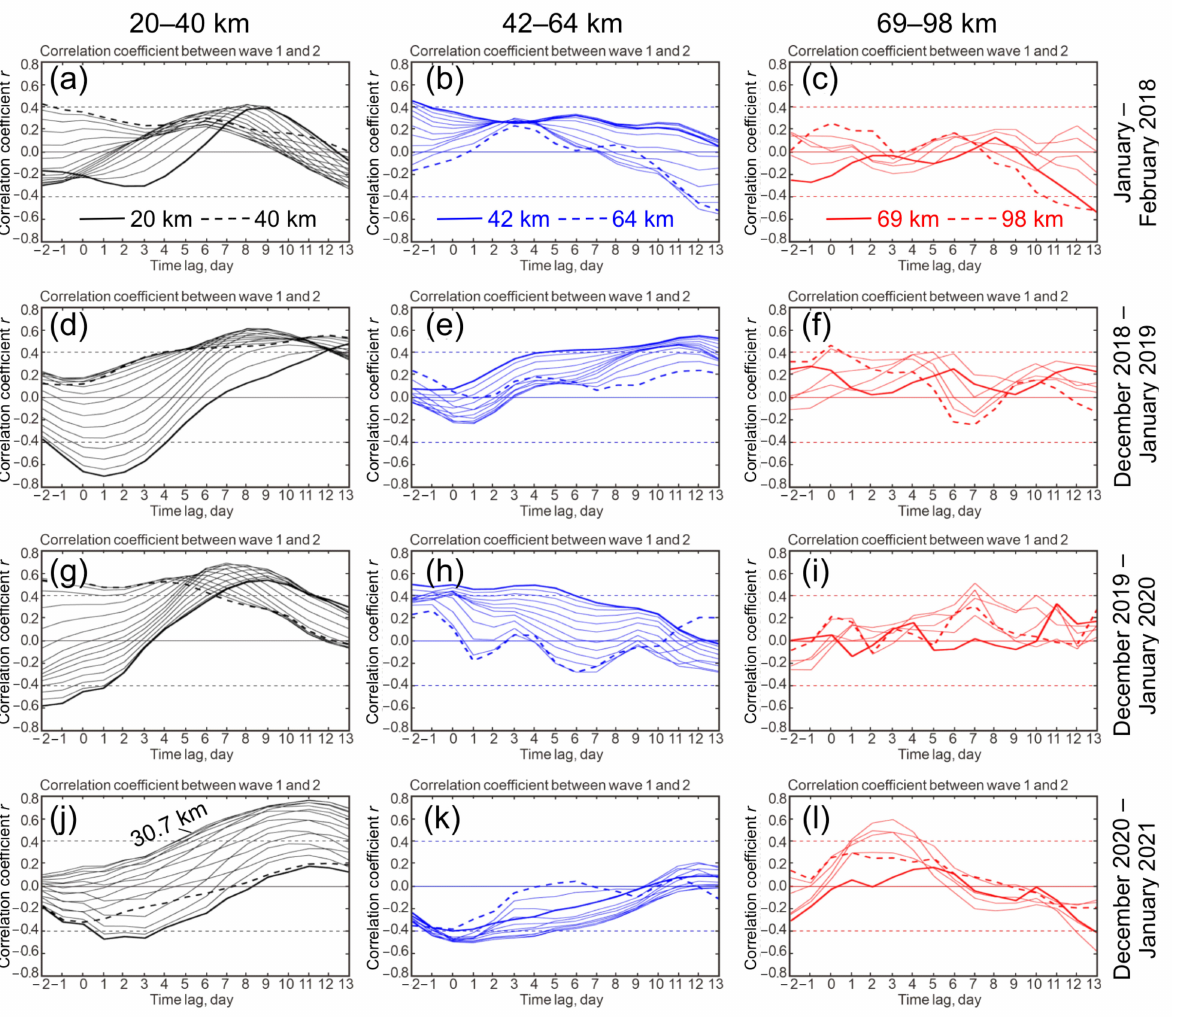
Figure 8. Moving correlation between amplitudes of wave 1 (Z1) and wave 2 (Z2) with time lag from –2 days to +13 days. Altitude ranges (left) 20–40 km, (middle) 42–64 km, and (right) 69–98 km are shown. Each curve represents a different pressure level, and the thick solid (dashed) curves show the lowest (highest) levels in each altitude range. From top to bottom: winters ( a–c ) 2018, ( d–f ) 2018–2019, ( g–i ) 2019–2020, and ( j–l )